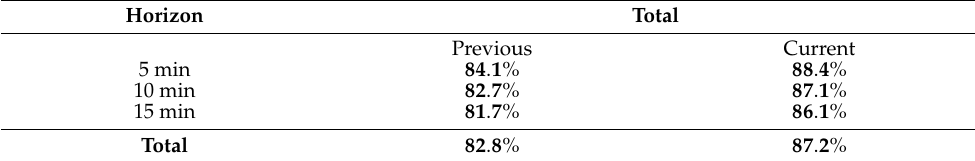
Table 4. Global Improvements with respect to prior